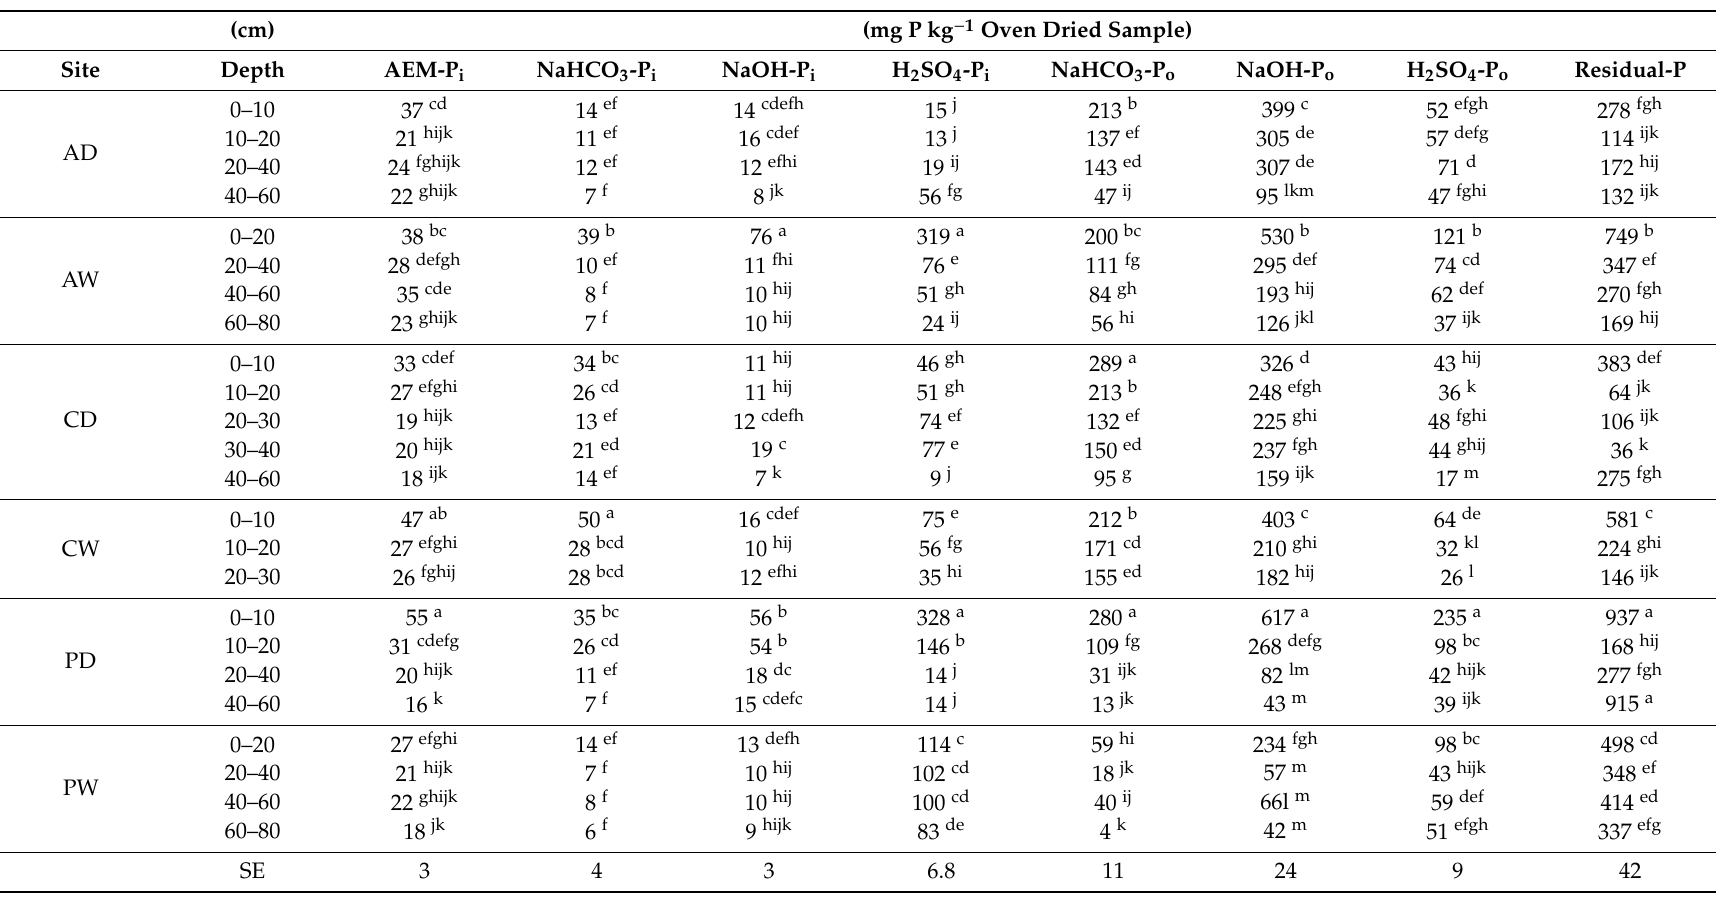
Table 1. Contents of phosphorus fractions extracted by sequential fractionation